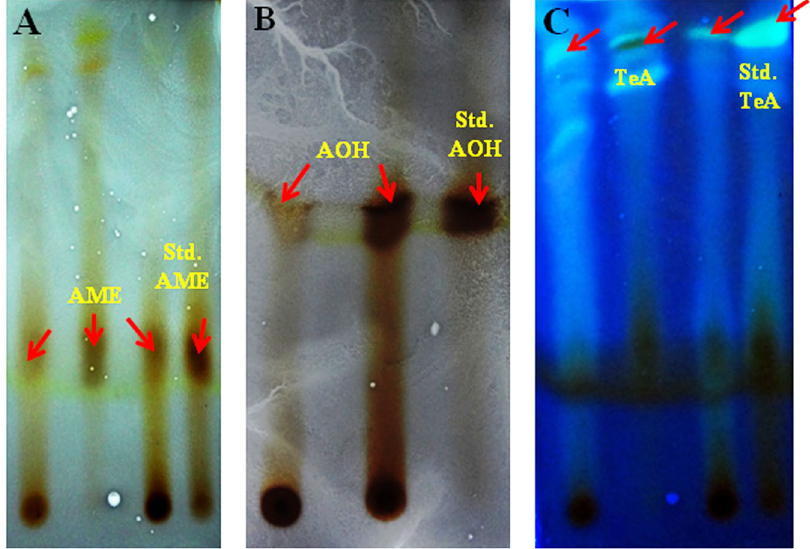
Figure 3. TLC analysis of different metabolites of Alternaria displaying different spots on TLC plates. ( A ) showing the spots of alternariol monomethyl ether (AME), ( B ) showing the spots of alternariol (AOH), and ( C ) showing the spots of tenuazonic acid (TeA), on the basis of their R f values. The standards of these toxins were also run on similar plates for comparisons of the R f values. The spots were visualized by spraying ferric chloride (FeCl 3 ) solution or under UV-light.